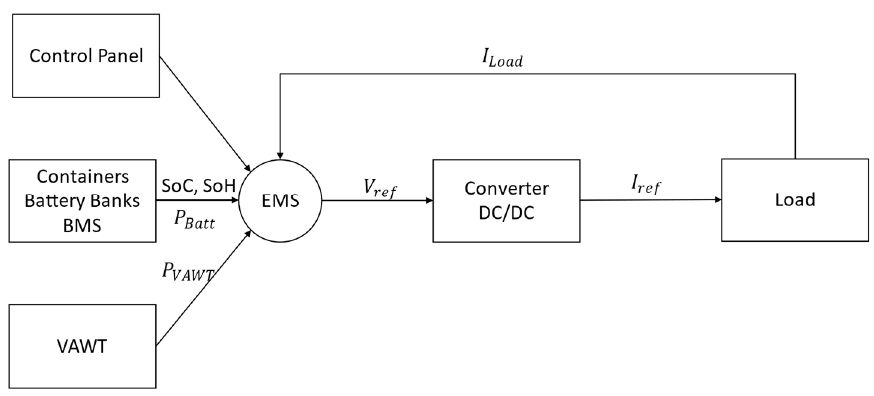
Figure 5. The proposed energy management systems (EMS) control system.